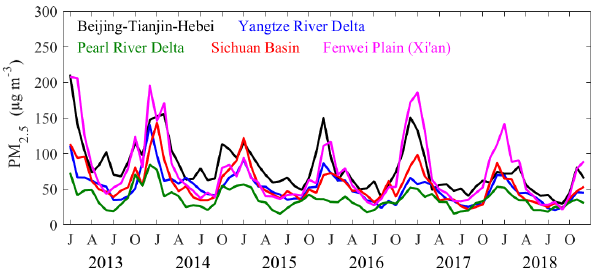
Figure 3. Time series in 2013–2018 of monthly mean PM 2 . 5 con- centrations over the five target regions. Values are averages from all sites in the region with over 70% data coverage for each of the 6